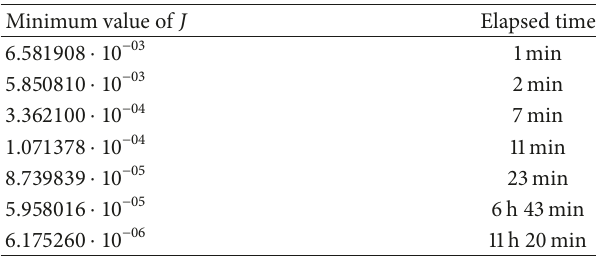
Table 2: Results on the hybrid